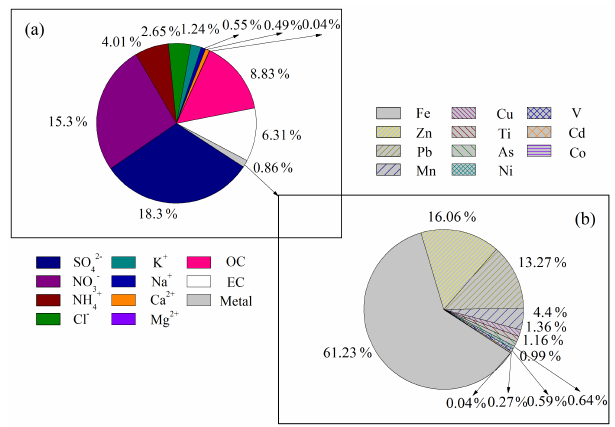
Figure 3. Pie charts showing the relative contribution of species for PM 2 . 5 in Qimu Island. Note the sum of percentage of identified species in PM 2 . 5 in (a) is 58.58%, while that in (b) is 100% be- cause the percentage is the ratio of every metal element to the total identified metal